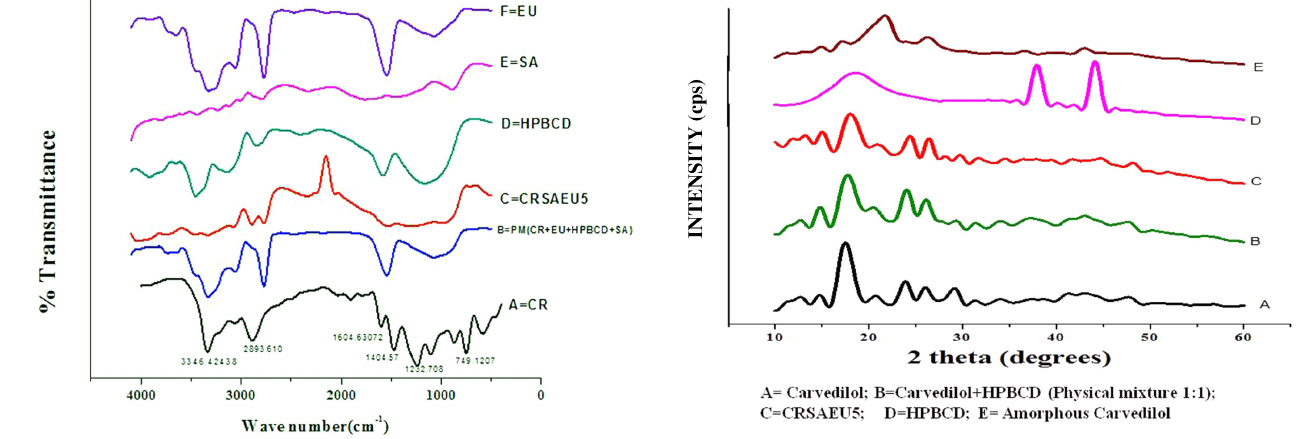
FIGURE 5 - FTIR spectra of CRSAEU5, physical mixture (PM), HPBCD, carvedilol, sodium alginate, Eudragit NE30D.